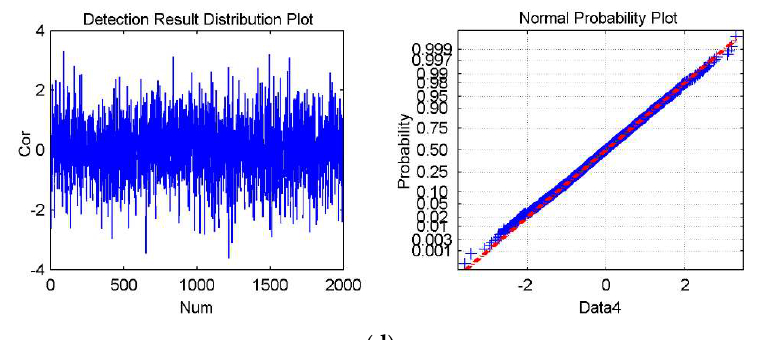
Figure 8. The experimental results for Watermark3 and Watermark4, which are not present in the cover data. ( a – d ) shows the detection result distribution plot and the normal probability plot of Data1, Data2, Data3, and Data4, respectively. The mean is 0.00043, and the standard deviation is 1.0128 in ( a ); the mean is −0.0288, and the standard deviation is 1.0186 in ( b ); The mean is 0.0105 and the standard deviation is 0.9956 in ( c ); The mean is −0.0199 and the standard deviation is 1.0003 in ( d ). Information 2018 , 9 , x